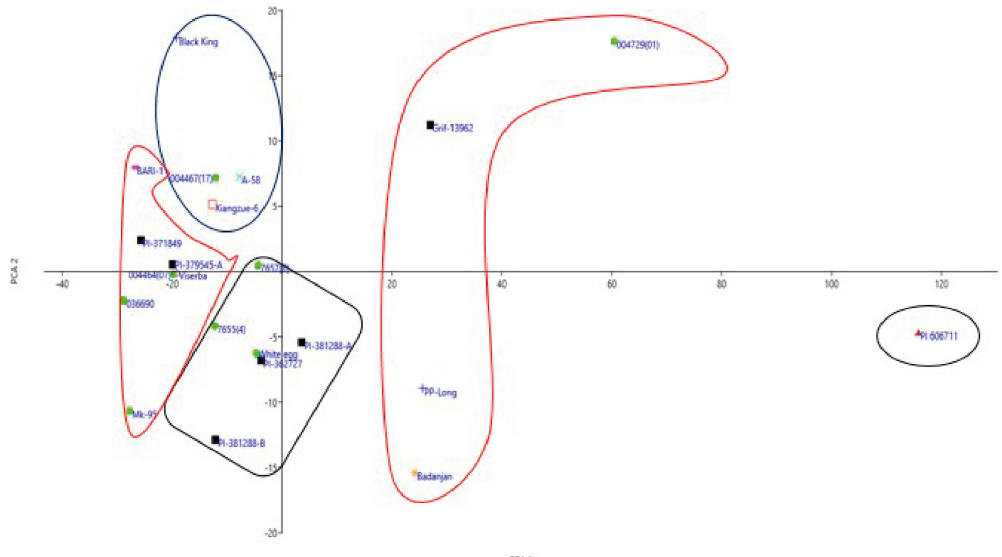
Figure 6: First ( X -axis) and ( Y -axis) principle components (90.758% and 6.419% of total variation explained, respectively) among 22 eggplant accessions (Pakistani and foreign eggplant